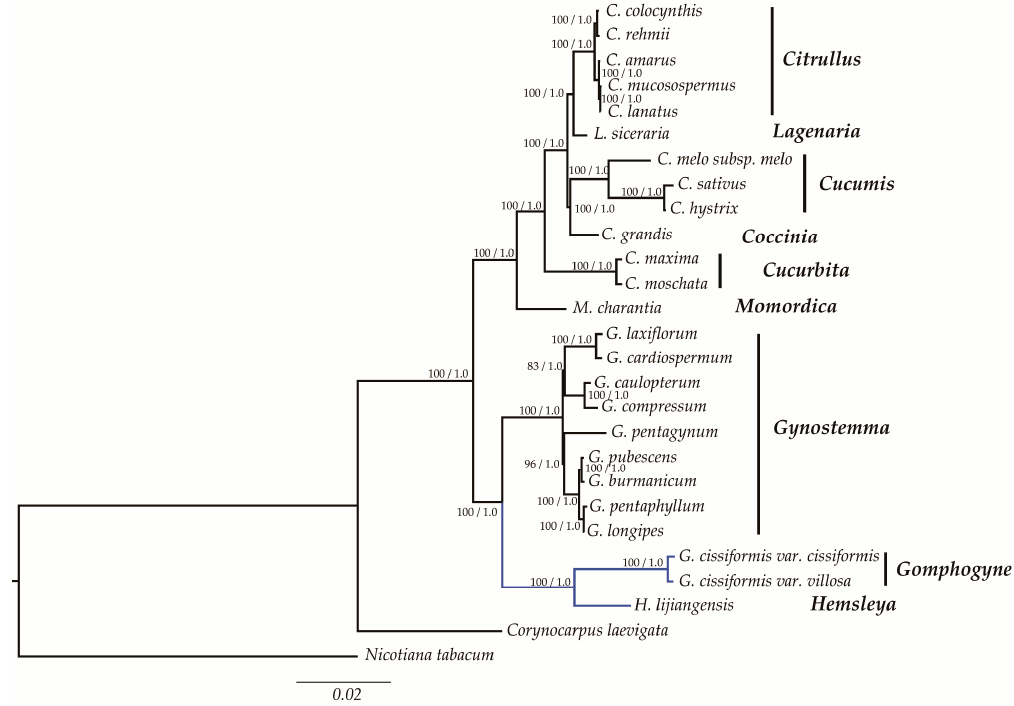
Figure 8. Phylogenetic relationship of the 27 species inferred from ML and BI analyses based on the complete cp genome sequences. The bootstrap values of ML analyses and Bayesian posterior probabilities are shown beside the clades. Corynocarpus laevigata , and Nicotiana abacum were used as outgroups. The clades in blue color showed the three newly sequenced species in our study.